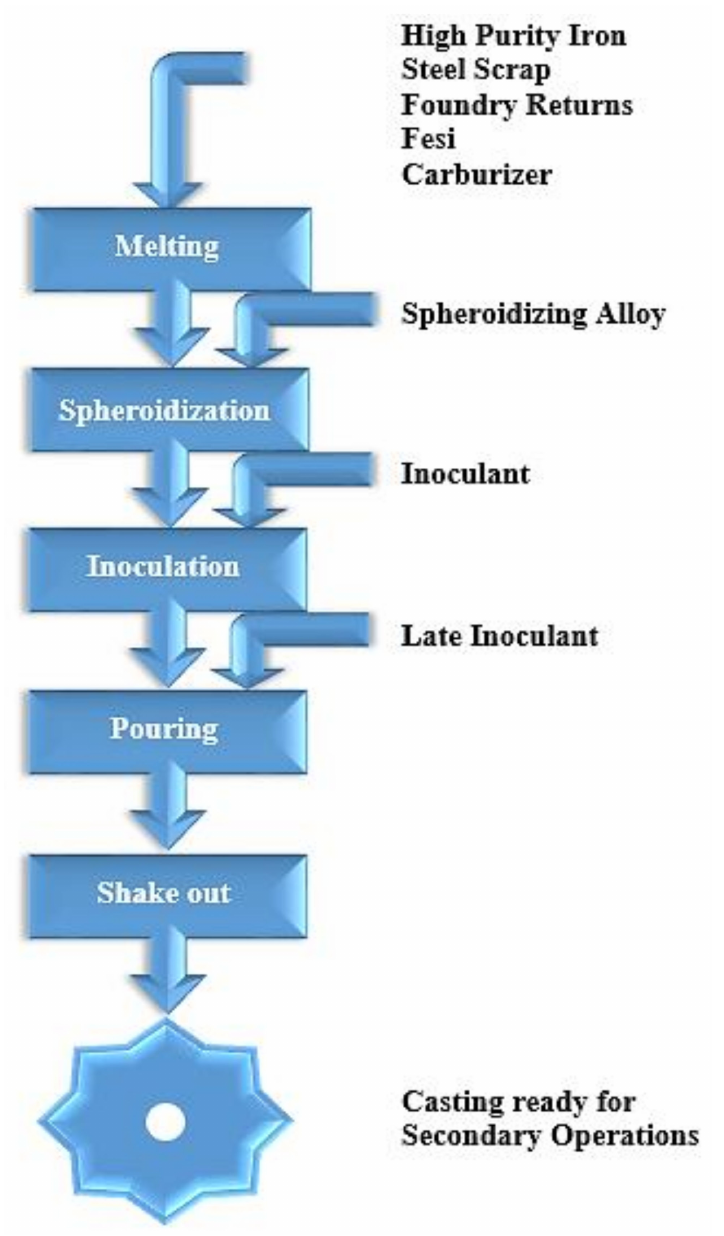
Figure 3. Schematic flowchart of ductile iron production